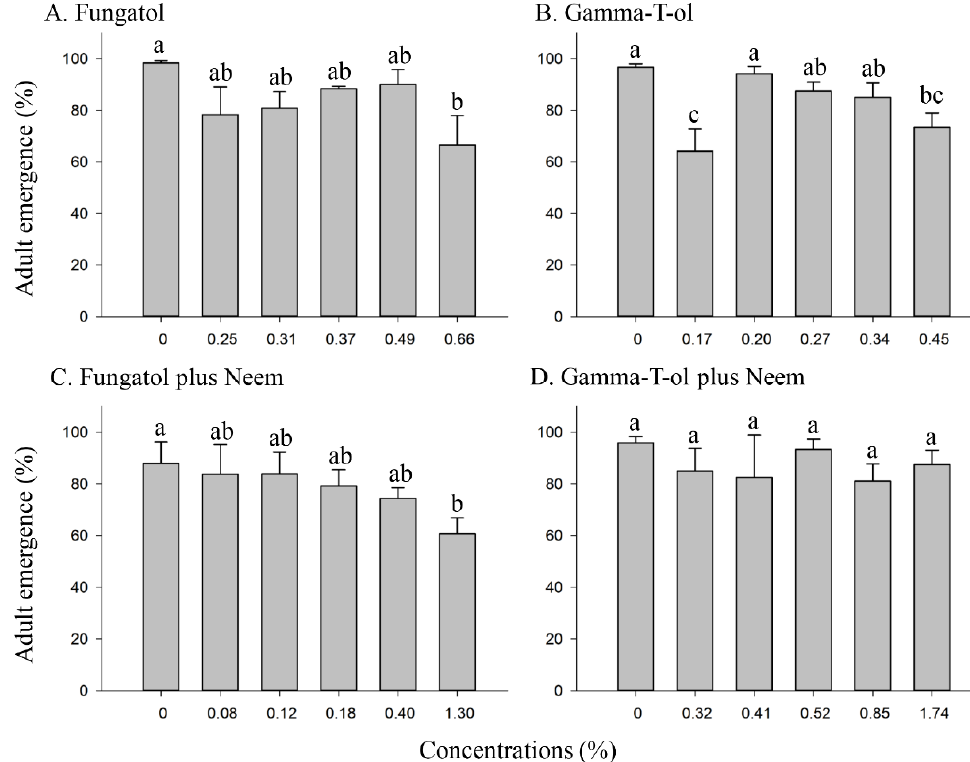
Figure 1. Effect of different concentrations of Fungatol ( A ), Gamma-T-ol ( B ), Fungatol plus neem ( C ), and Gamma-T-ol plus neem ( D ) on adult emergence of A. colemani from treated mummies in the laboratory. One-way ANOVA with the Duncan multiple comparisons test revealed significant differences between the concentrations of Fungatol ( A ), Gamma-T-ol ( B ), Fungatol with neem ( C ), and Gamma-T-ol plus neem ( D ). Different lowercase letters above bars represent significant differences at p < 0.05. Data presented are mean ± SEM.